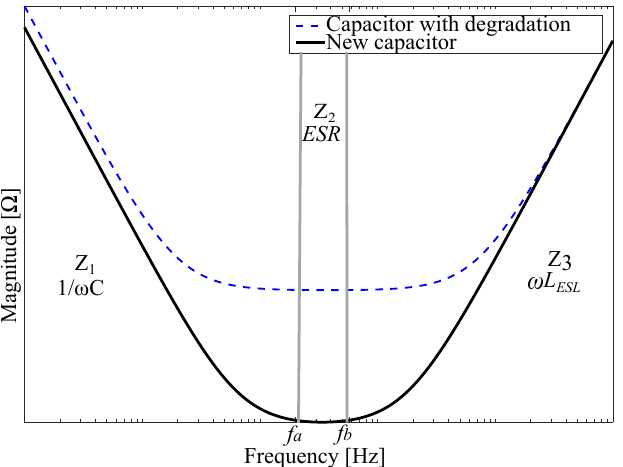
Figure 1. Impedance characteristics of a degraded and non-degraded